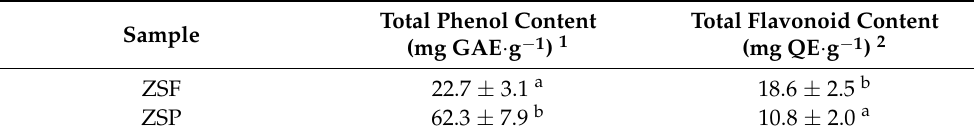
Table 4. Total phenolic content and total flavonoid content of Zanthoxylum schinifolium